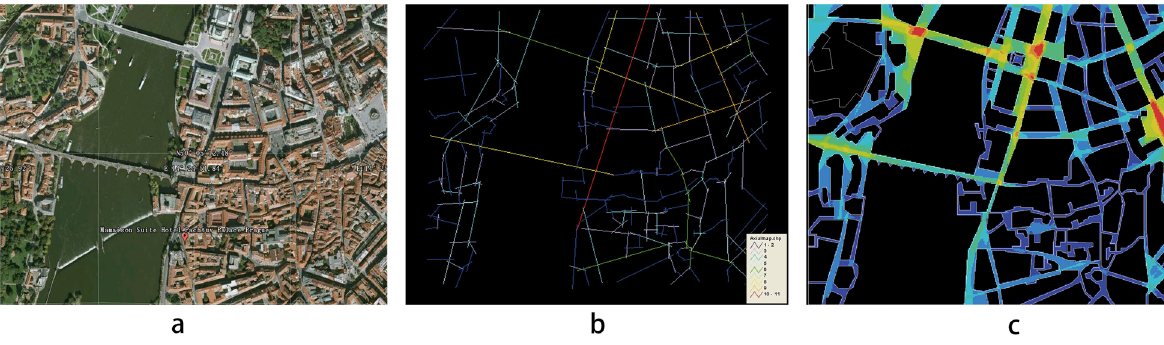
Fig. 8 The satellite image ( a ) the aerial map ( b ) and the VGA map ( c